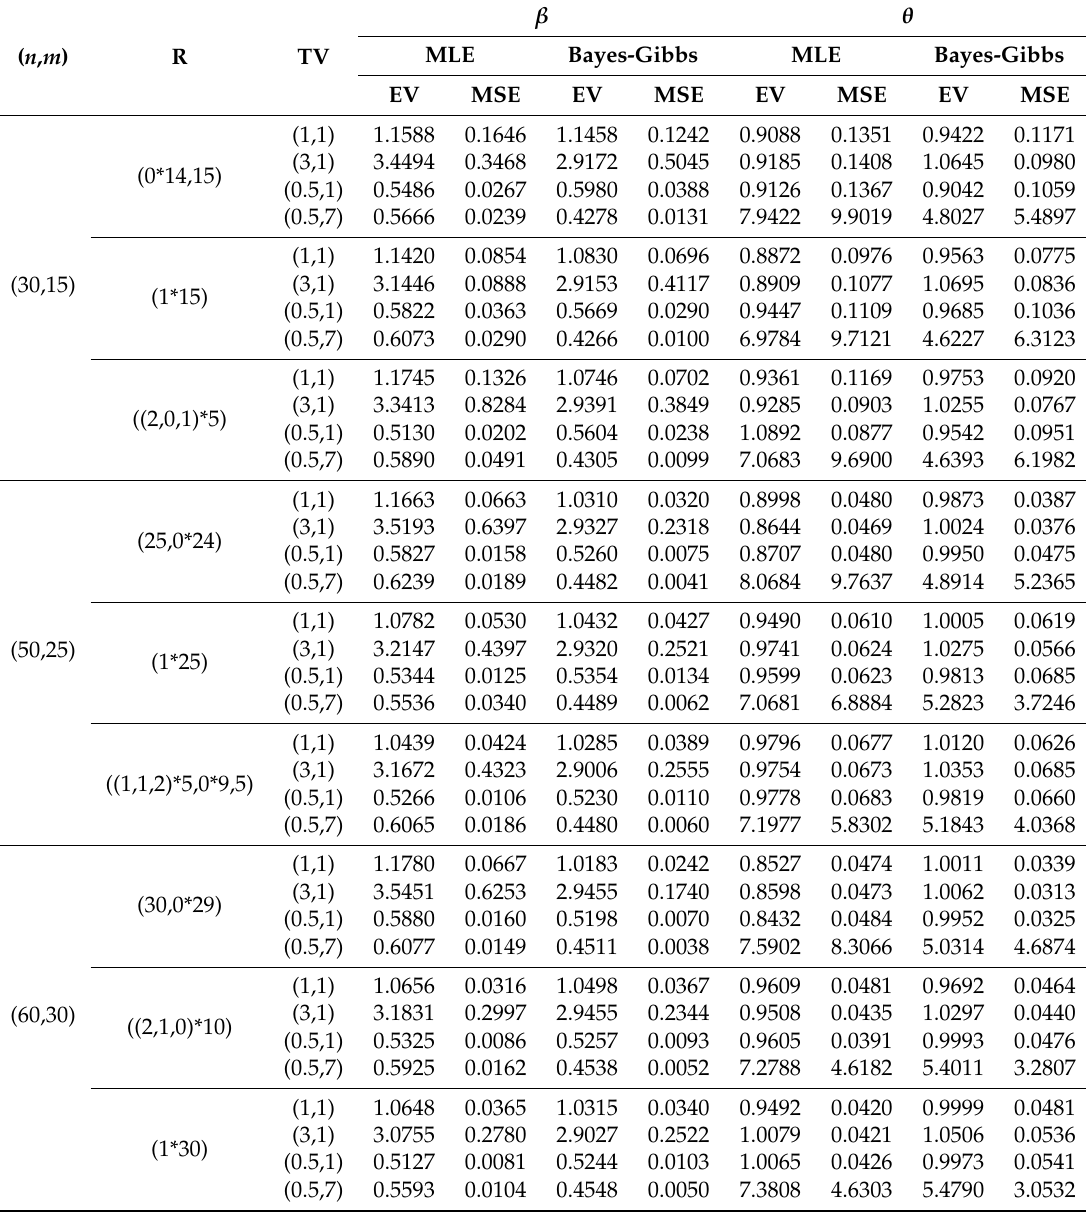
Table 2. Expected values (EVs) and mean square errors (MSEs) of point estimators when T = 1.